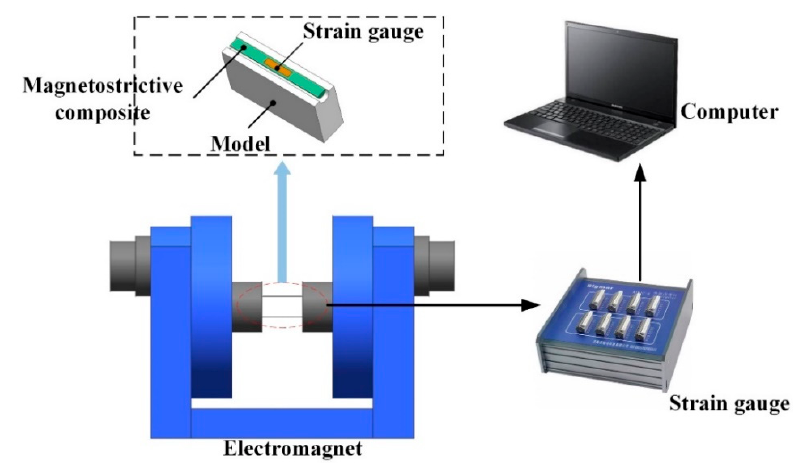
Figure 6. Testing device of magnetostrictive composite material.